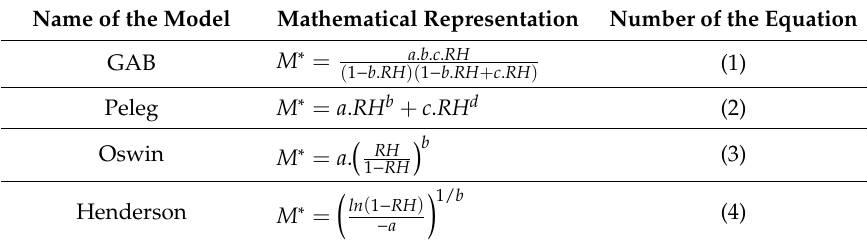
Table 2. Mathematical models selected in this